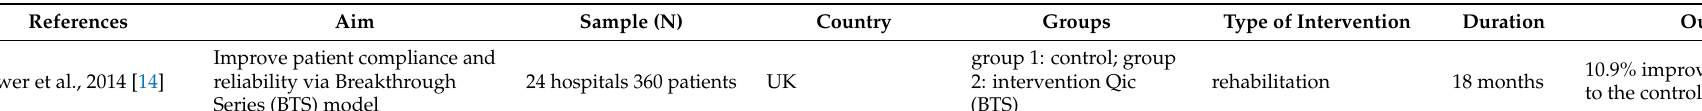
Table 1. Studies’